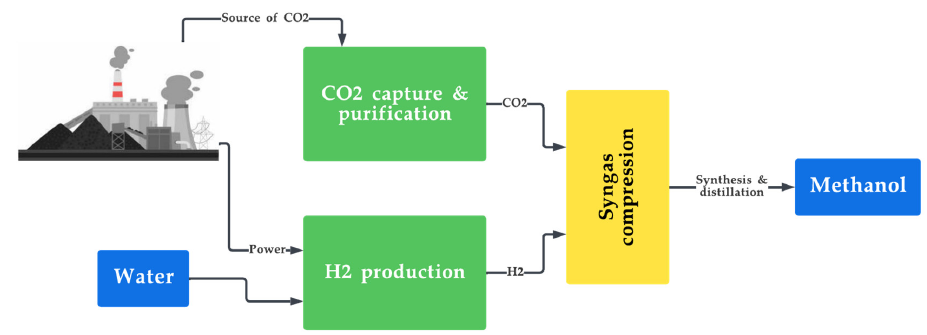
Figure 5. Production of synthetic fuels from CO 2 capture and H 2 production.